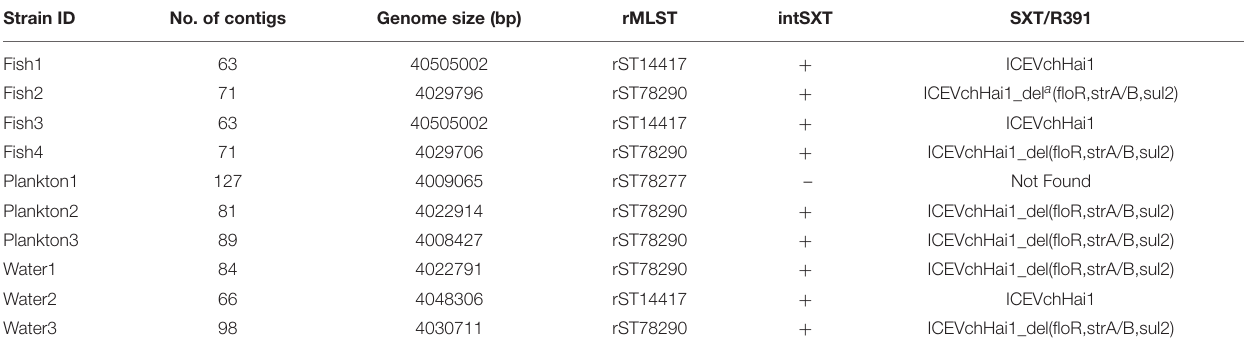
TABLE 2 | Genomic sequence data, virulence profile and occurrence of antimicrobial resistance genes in the V. cholerae strains. Strain